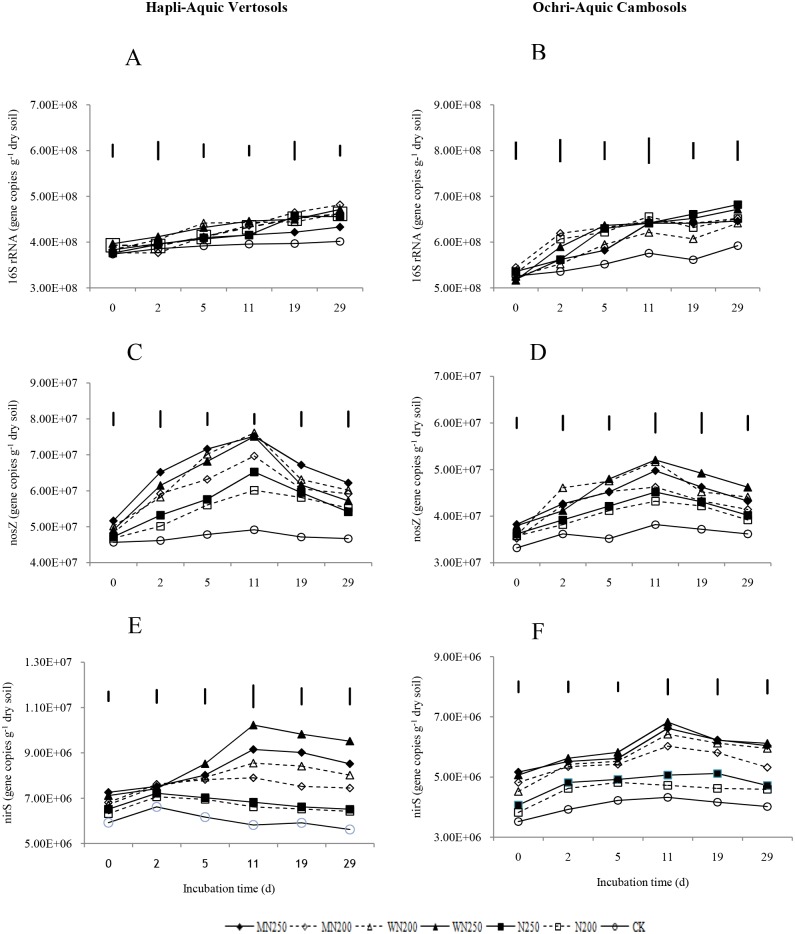
Abundances of the 16S rRNA (A, B), nosZ (C, D) and nirS (E, F) gene copies in the Hapli-Aquic Vertosols and the Ochri-Aquic Cambosols soils.The vertical bars represent LSD0.05.